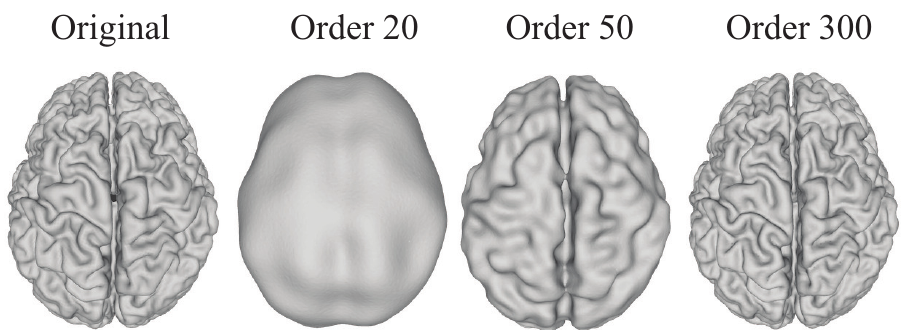
Figure 11. Reconstruction of the surface of a brain from the Zernike moments computed from a triangle mesh representing its boundary. We compare the reconstructions generated from three different maximum order N , N = 20, N = 50, and N = 300. The original brain surface is shown on the left. All figures were generated with MeshLab